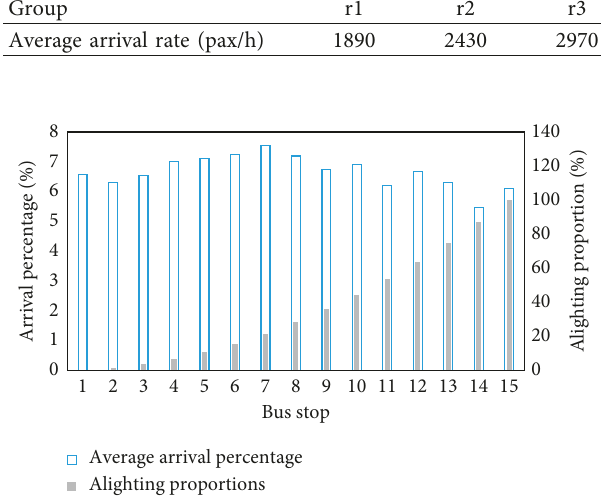
Figure 3: Percentage of average passenger arrivals and alighting at each